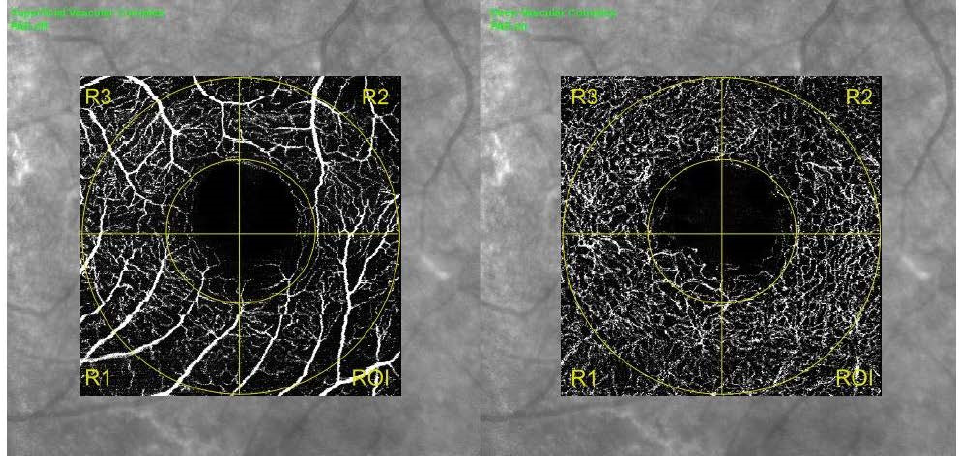
Figure 2. Standard grid applied for foveal and parafoveal zone isolation in SCP (left side of the image) and DCP (right side of the image). ROI indicates the quadrant matching with the zone of tissue loss in B scan images of TL group. Analysis of VD and PD detected a lower parafoveal PD in SCP of ROI regions compared to the remaining 3. DCP = deep capillary plexus; PD = perfusion density; ROI = region of interest; SCP = superficial capillary plexus; VD = vessel density .